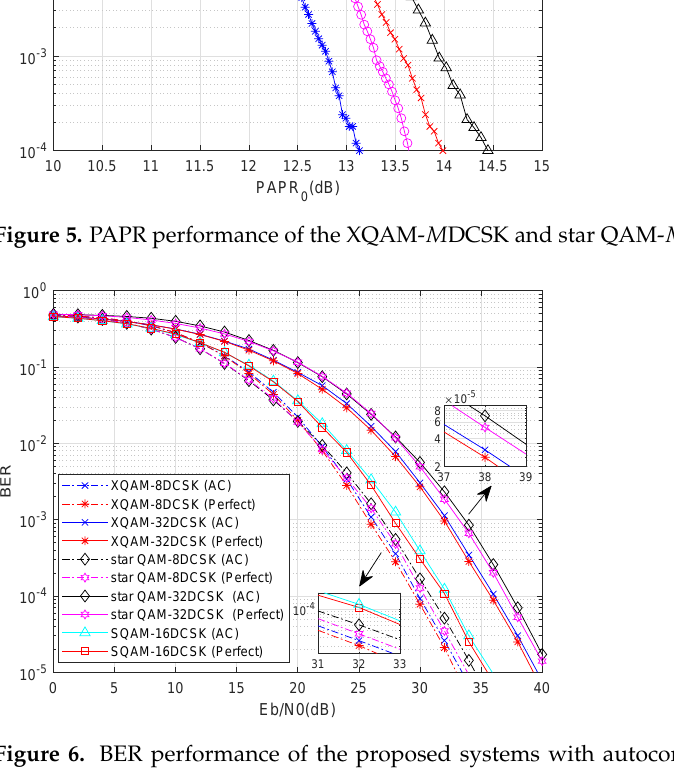
Figure 6. BER performance of the proposed systems with autocorrelator and the systems with perfect